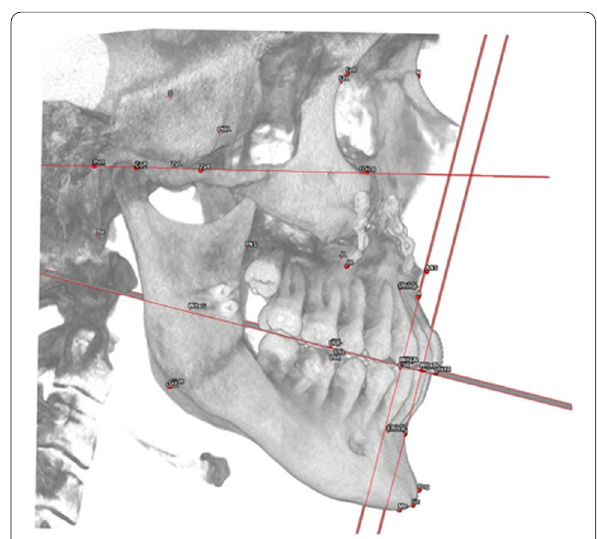
Fig. 3 View of a sagittal skeletal analysis in a PostOp